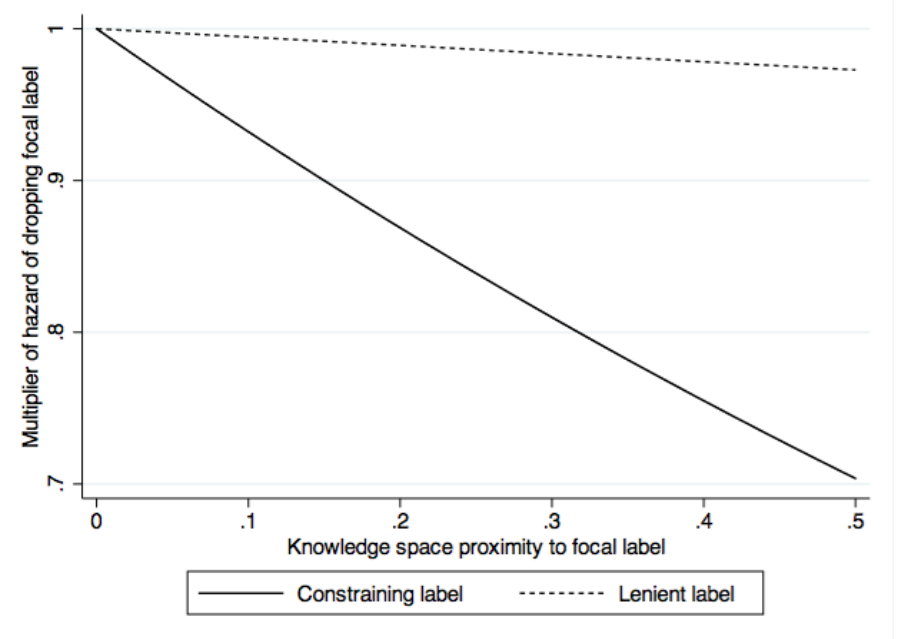
Figure 6: Effects of knowledge proximity on the hazard of dropping a label, by leniency (from Table 4, model